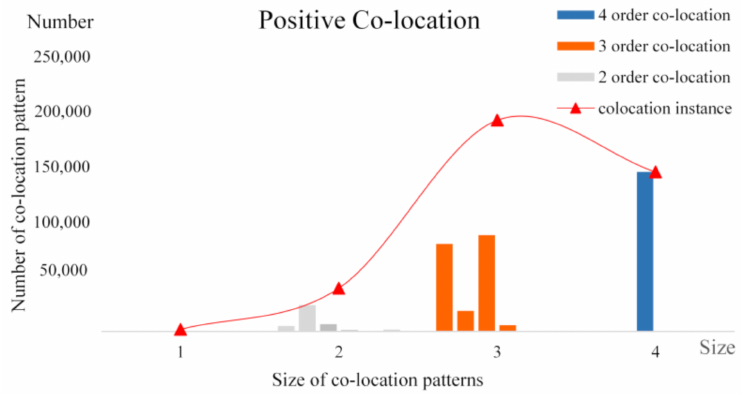
Figure 5. The line charts represent the sum of the total number of positive C-LP for each SZ, and the bar charts represent the number of detailed positive C-LP for each SZ.